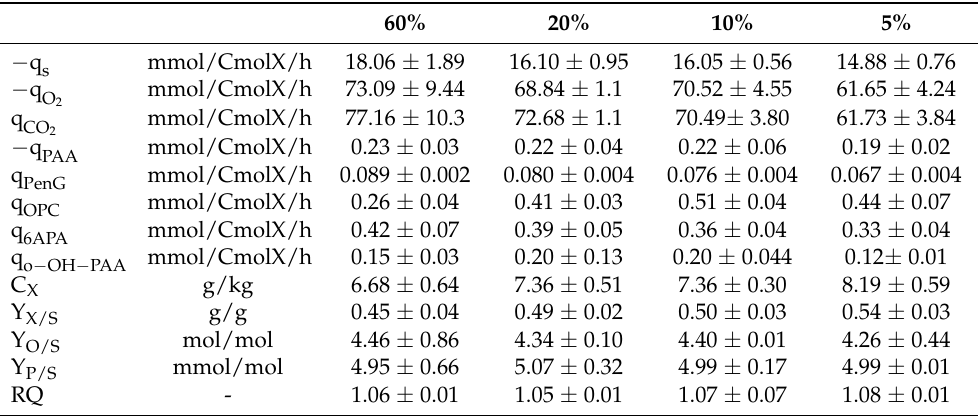
Figure 2. The biomass-specific PenG production rate (q ) at DO-shift experiments, and the data at PenG different DO levels are the mean ± standard deviation of at least three replicate experiments. Table 1. Comparison of the biomass-specific rates and relevant yields of Penicillium chrysogenum Wisconsin 54-1255 on glucose obtained from DO-shift cultures at the average dilution rate of 0.05 h − 1 in the time range of 100–300 h of cultivation. Measurements are given as average ± standard deviation of at least two individual